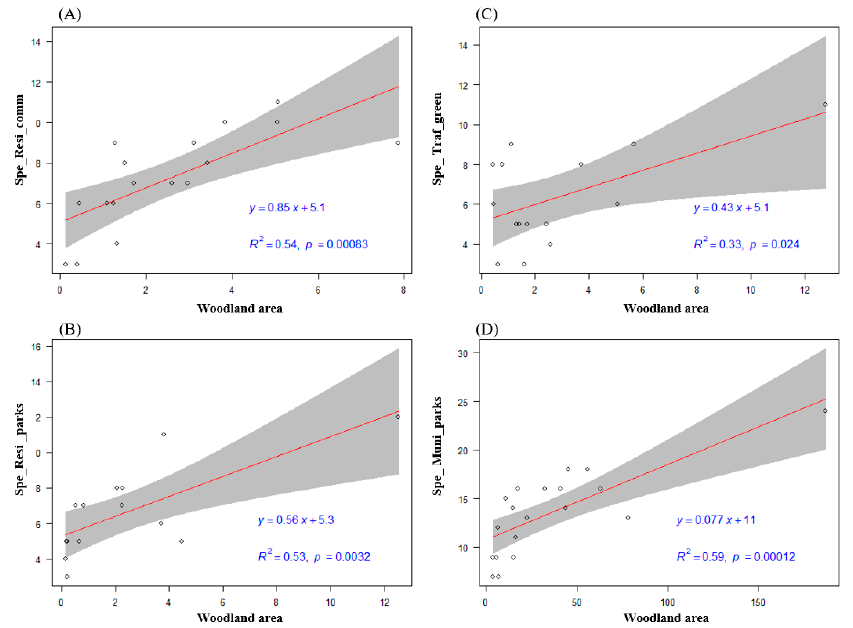
Figure 4. Species-woodland area relationships in different urban green spaces during the breeding season. ( A ) In residential communities; ( B ) In residential parks; ( C ) In traffic green belts; ( D ) In municipal parks.